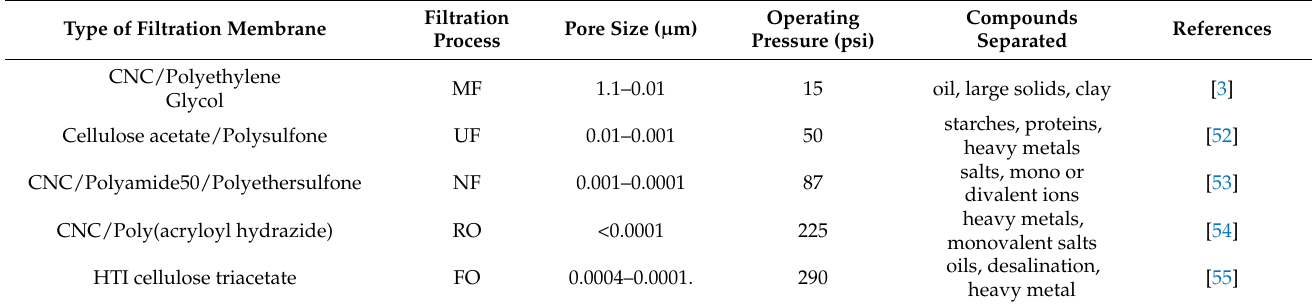
Table 1. Classification and characteristics of the cellulose-derived membrane separation process. Type of Filtration